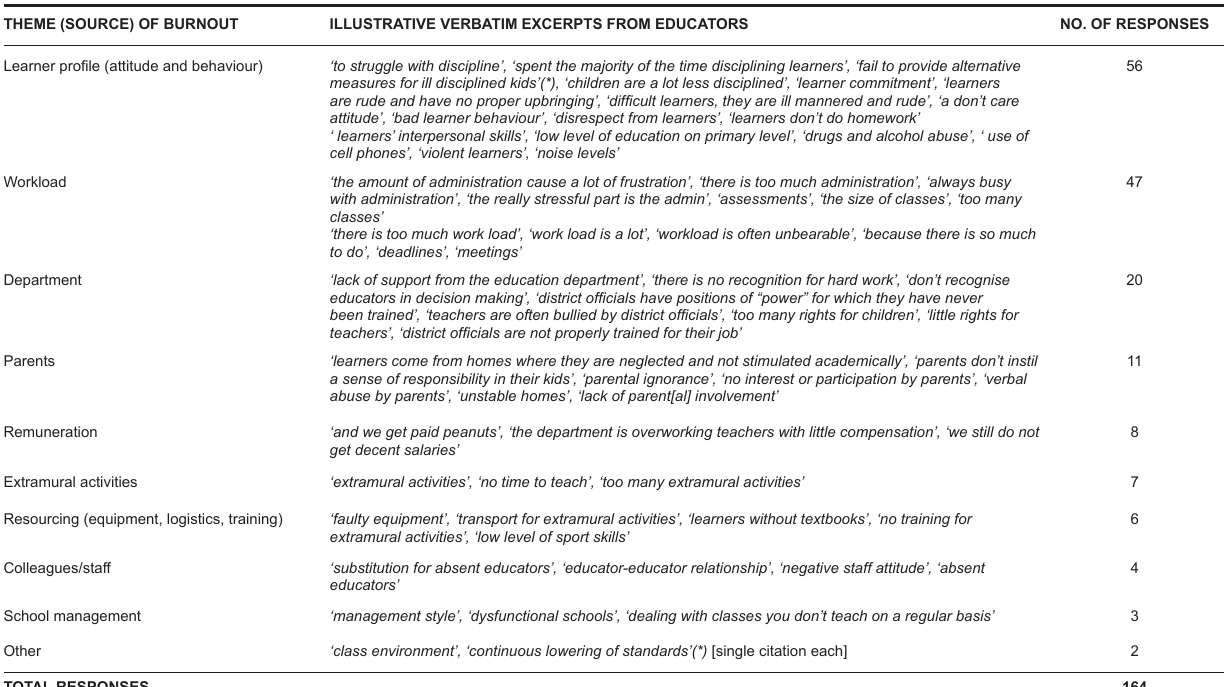
TABLE 3 Themes indicating probable sources of stress and burnout among educators (text